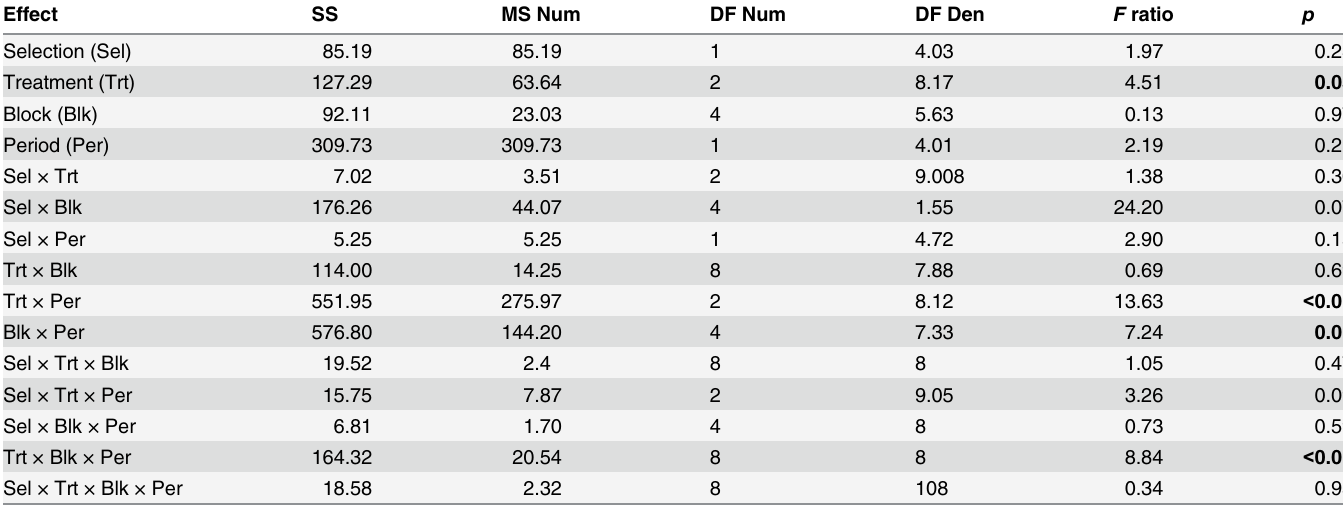
Table 2. Effect of cold shock on fecundity (Experiment 1).